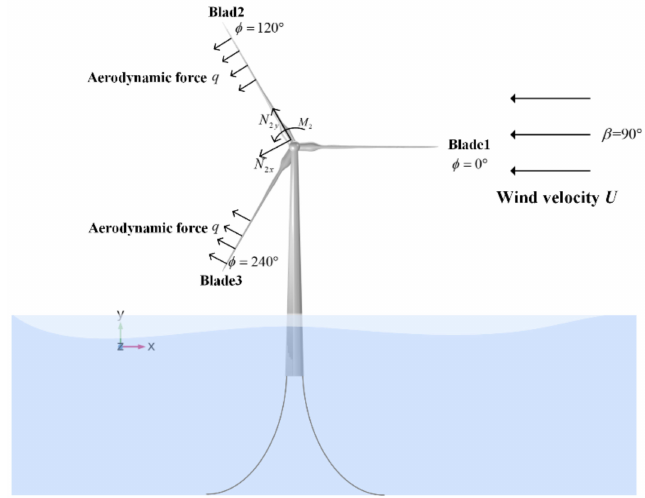
Figure 3. Schematic diagram of blade force under wind